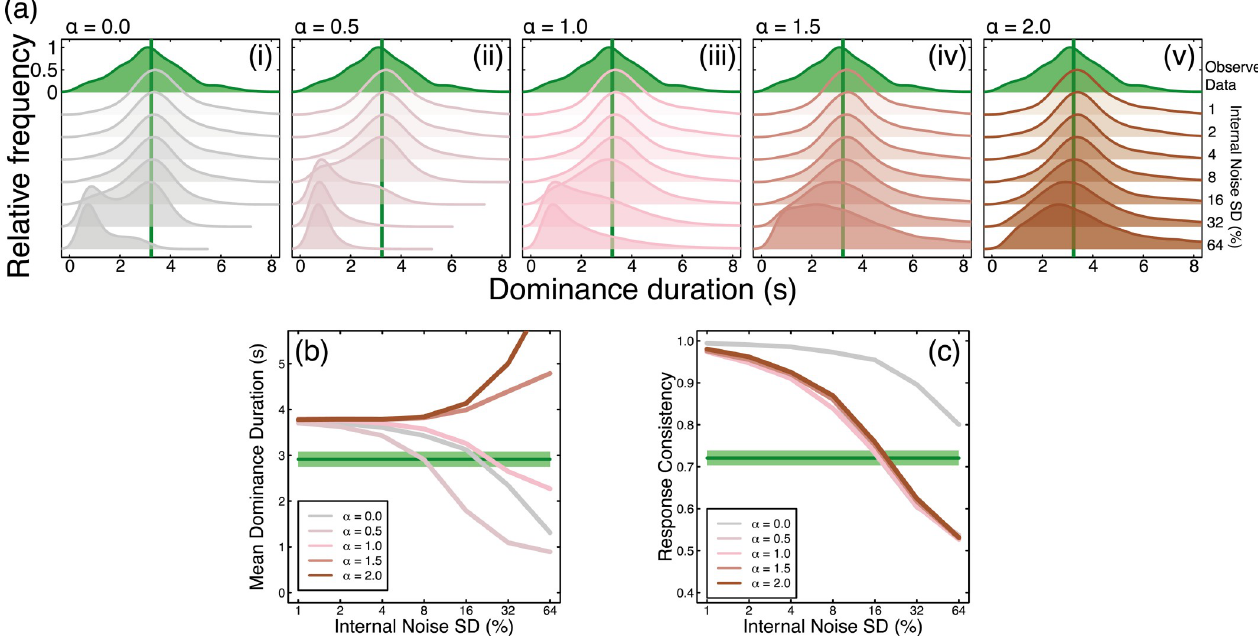
Fig 5. Summary of model behaviour for internal noise amplitude and spectral slope estimation. (a) The histograms of dominance durations for each spectral slope ( α = 0.0–2.0) and level of internal noise (SD = 1%– 64%). Within each subplot, the uppermost (green shaded) histogram shows the equivalent human data for a stimulus temporal frequency of 1/8Hz and a contrast modulation of SD = 16%. The solid vertical green line marks the average dominance duration for human observers. Histograms below show model dominance duration distributions for each internal noise level. (b) Average dominance durations of the model for each spectral slope (coloured lines). The green line and shaded area mark human average dominance duration and ± 1SE of the mean, respectively. Average dominance duration was affected by internal noise once its standard deviation was equivalent to 4% contrast. Noise with steeper slopes ( α = 1.5–2.0) increased mean dominance duration as a function of noise contrast, while noise with shallower slopes decreased mean dominance duration. (c) Response consistency decreased as a function of internal noise contrast for all spectral slopes. The green line and shaded area mark human observer average consistency and ± 1SE of the mean, respectively. For all α > 0, response consistency reached human levels at an internal noise contrast of 16%.